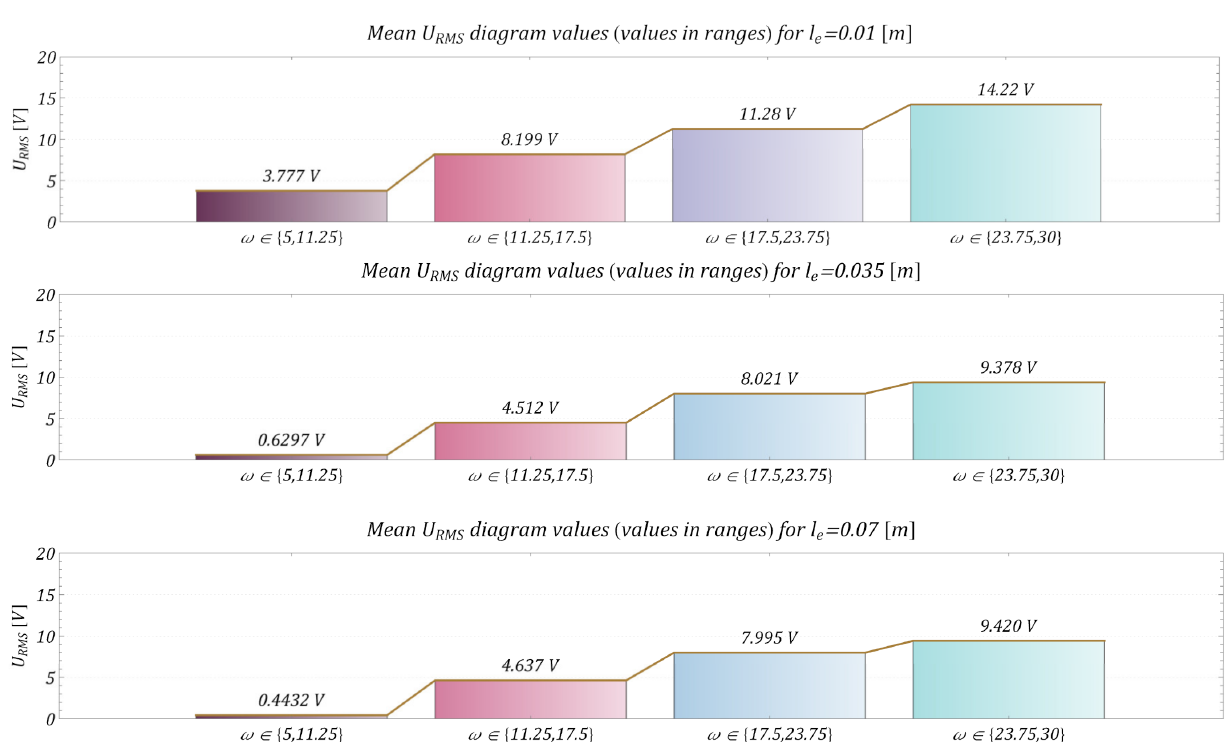
Figure 19. RMS voltage output related to selected bounds of angular velocity for selected l e